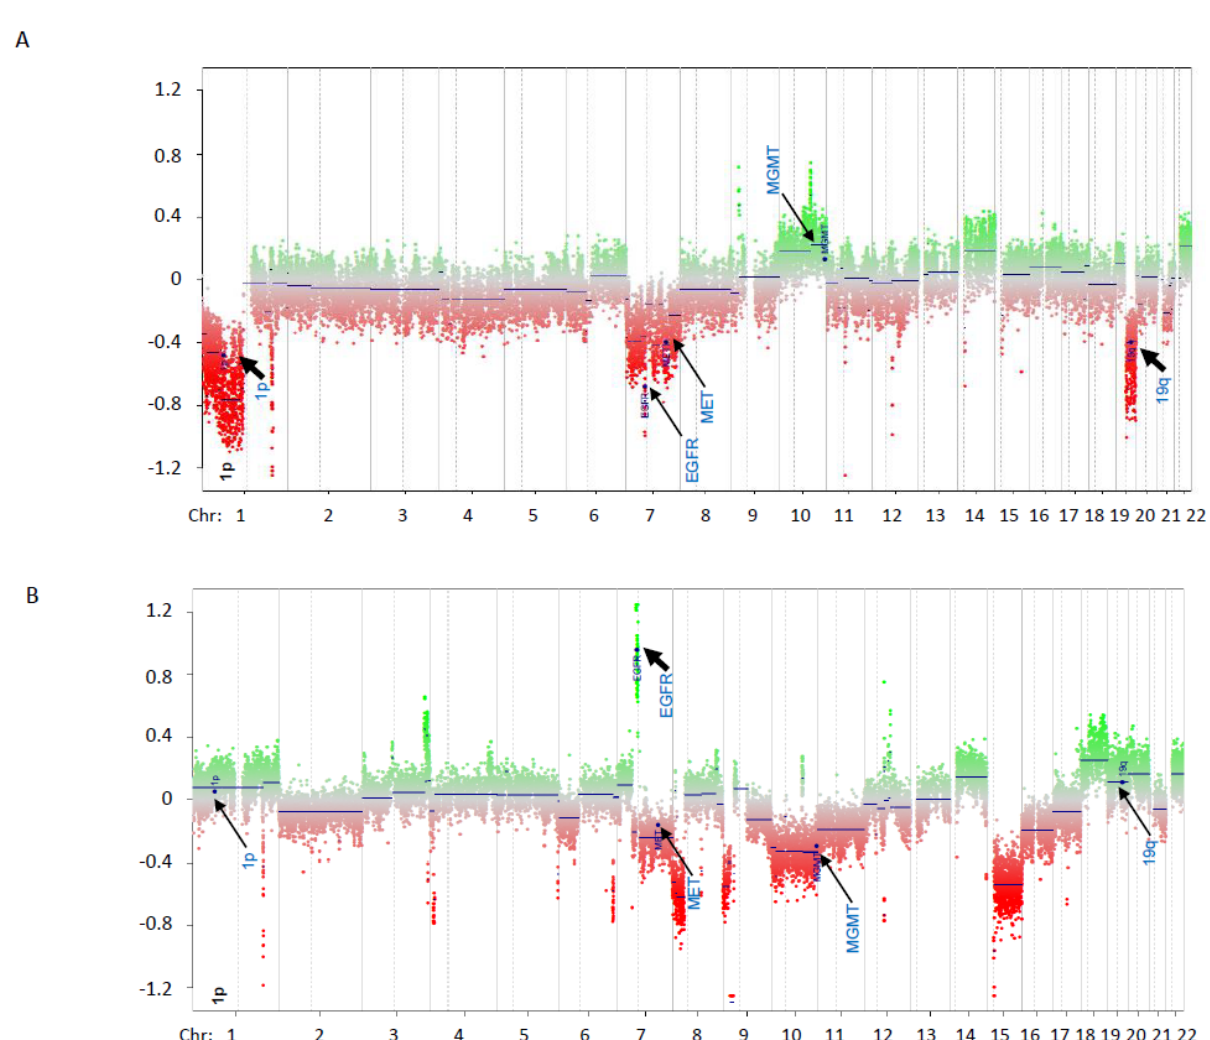
Figure 3. Genome-wide copy number analysis from methylation array data (Infinium Methyla- tionEPIC BeadChip). All chromosomes are represented in the X-axis. Normalized copy number is represented in Y-axis (baseline = 0). Green dots represent probes with normalized copy number above 0 while red dots represent probes with normalized copy number below 0. Positions of probes for 1p, 19q, EGFR, MGMT and MET are indicated by arrows. ( A ) Example of genome-wide copy number analysis with 1p19q co-deletion (Sample 44). Instances of 1p19q co-deletion are highlighted by black arrows. ( B ) Example of genome-wide copy number analysis with EGFR amplifica- tion. EGFR amplification is highlighted by a black arrow.